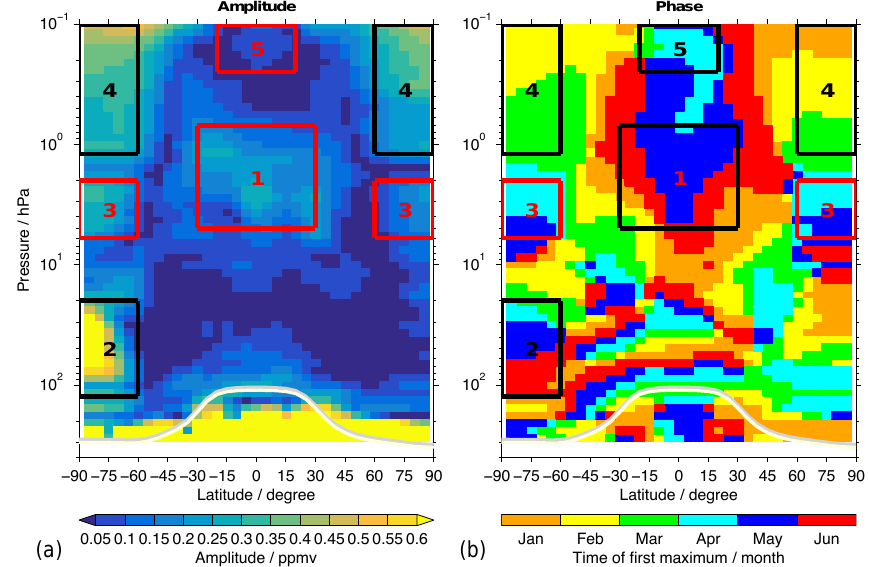
Figure 6. As Fig. 1 but here for the semi-annual variation. Note that the range of amplitudes is smaller here. The phase denotes the month of a calendar year where the first water vapour maximum is found. The example is again based on the MLS data